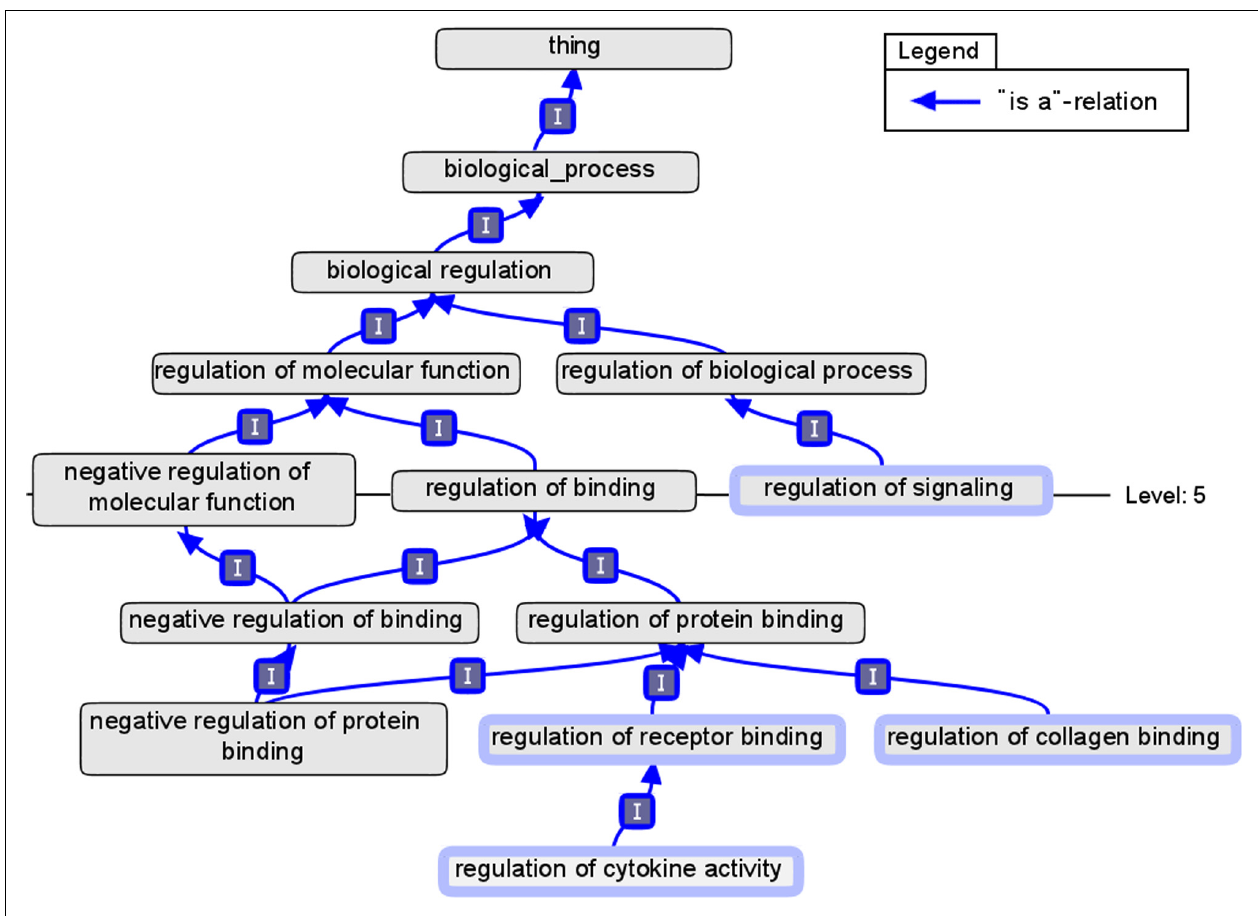
FIGURE 2 |A modified screenshot of the Gene Ontology using OBOEdit. The node “thing” was added as root of the ontology and marks the first level.The marked nodes have a thicker